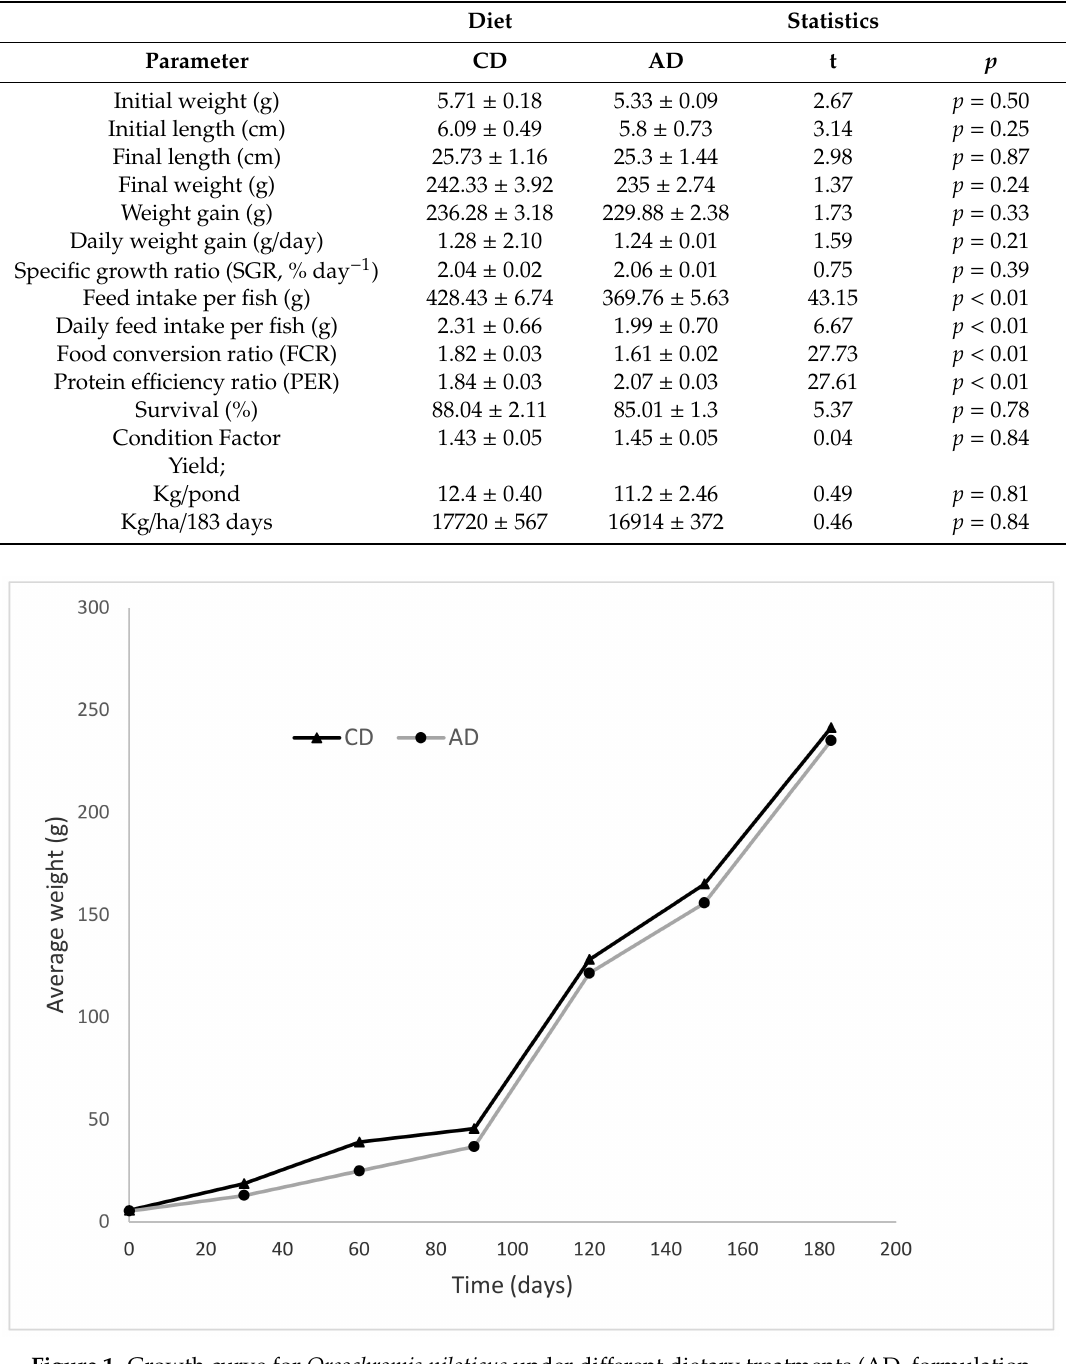
Table 4. Growth performance and yield of tilapia fed on control (CD) and experimental (AD) diets (mean ± SE).